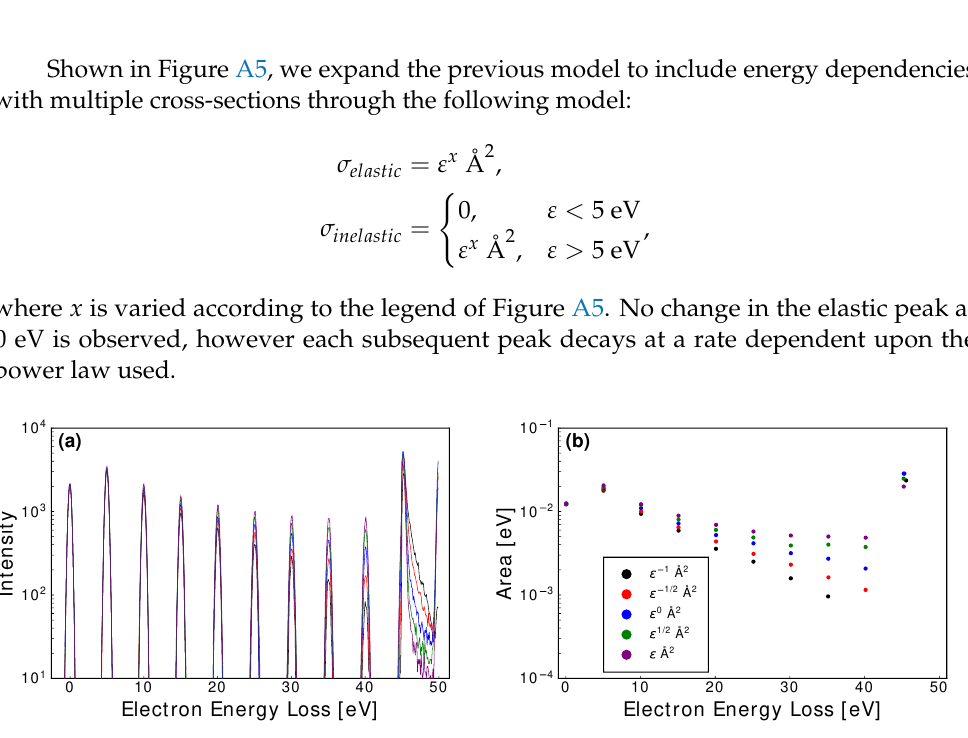
Figure A5. Simulated EELS ( a ), and area under each peak ( b ), as a function of the electron energy loss for a single elastic and inelastic cross-section, but both now with an equal power law functional form defined by the legend in ( b ). A distinct trend is observed, where the power law is proportional to the each cross-section’s